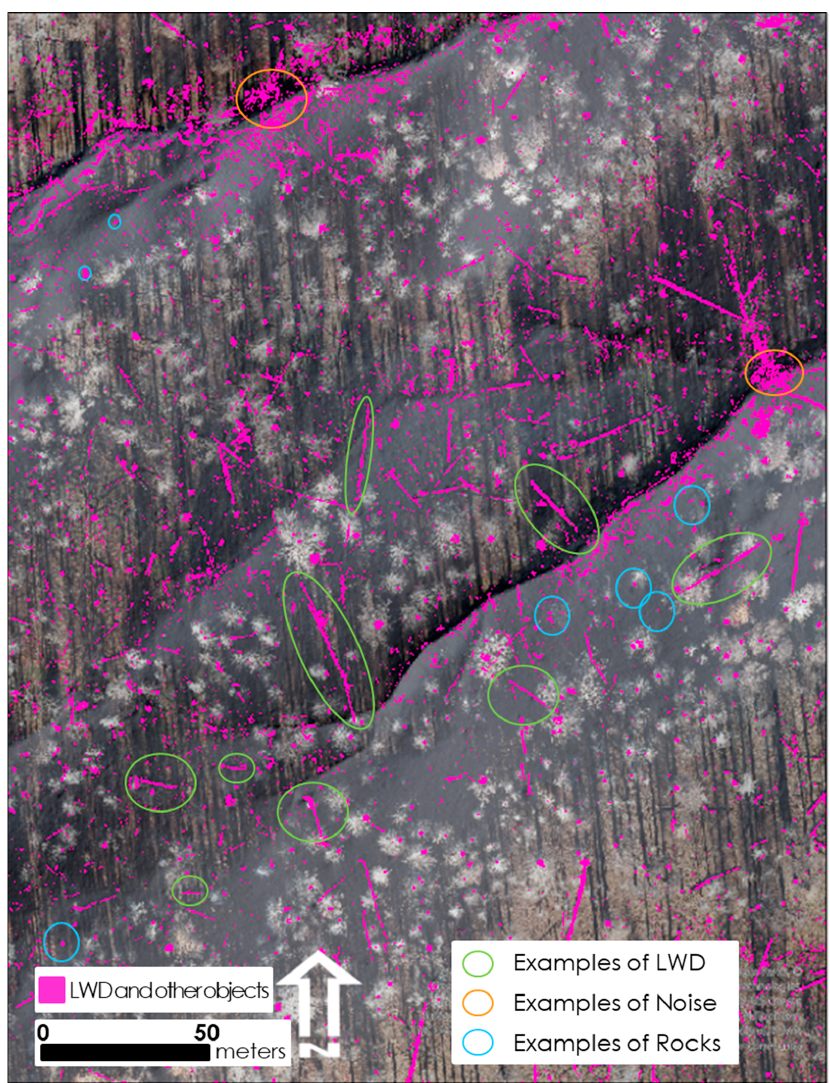
Figure 3. LWD extraction and features left behind in the filtering process.